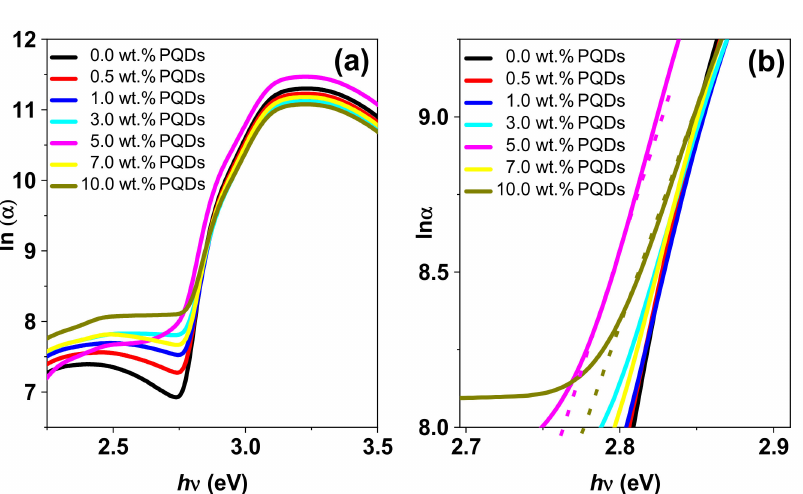
Figure 5. ( a ) Logarithm of the absorption coefficients and ( b ) magnification of the MEH–PPV/PFO hybrid, CsPbBr 3 -PQDs, and PQDs/(MEH–PPV/PFO) composite thin films as a function of the photon